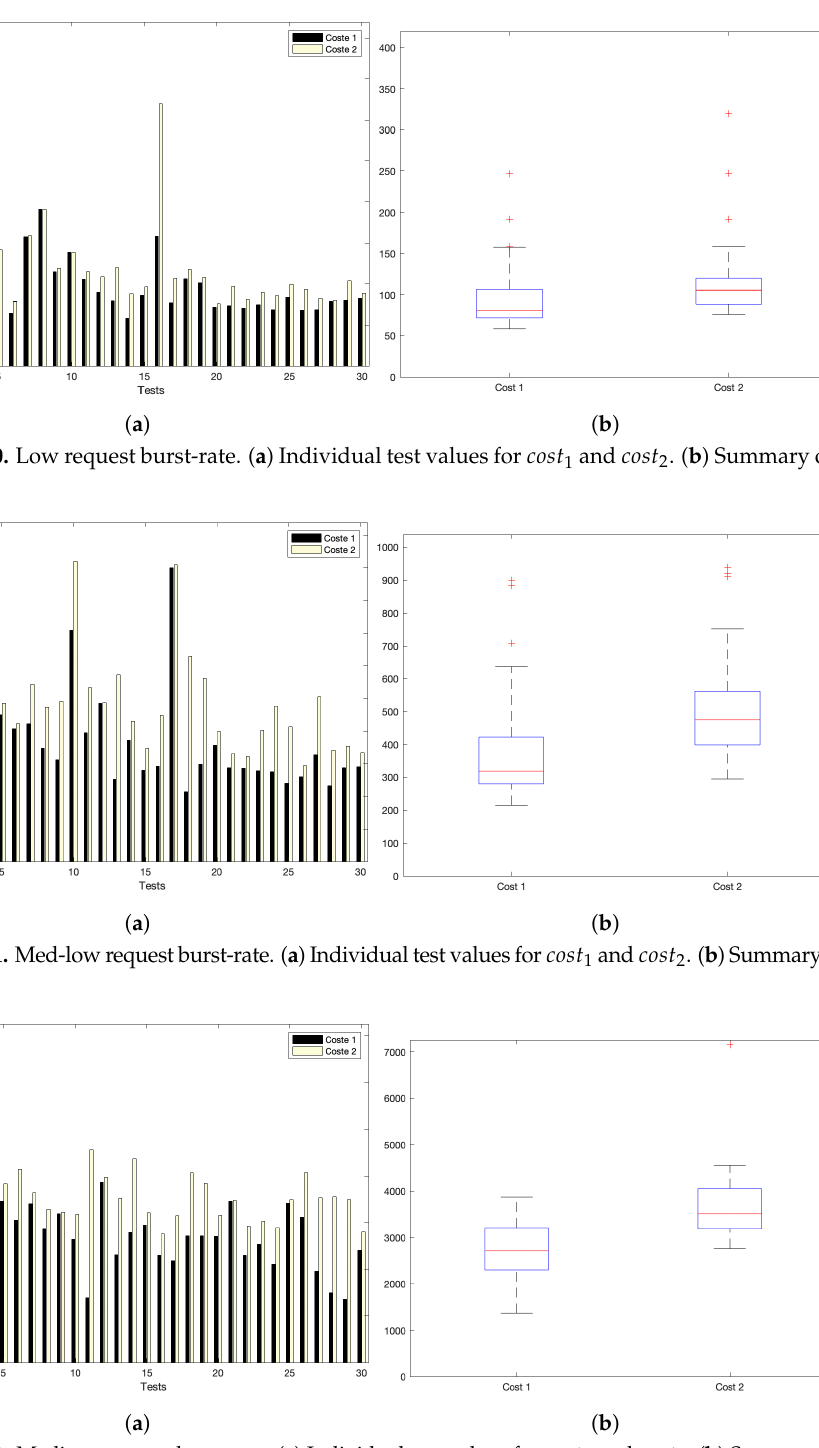
Figure 12. Medium request-burst rate. ( a ) Individual test values for cost 1 and cost 2 . ( b ) Summary